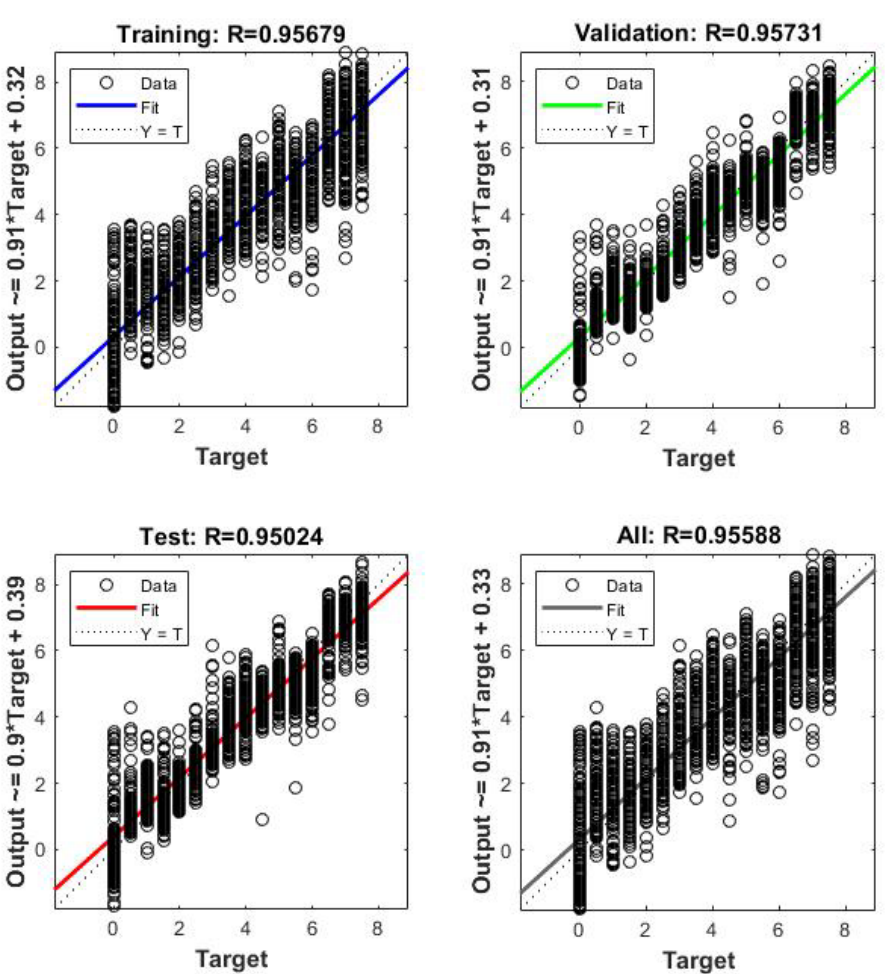
Figure 9. Regression charts received from the Neural Network Training tool.